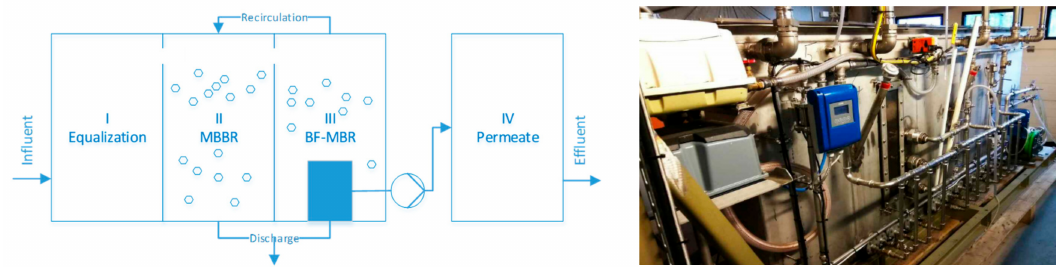
Figure 1. The BF-MBR pilot plant: Schematic diagram ( left ) and the photo of installation ( right ). Wastewater was supplied at 0.3 m 3 /day through the screens to the equalization tank (I)